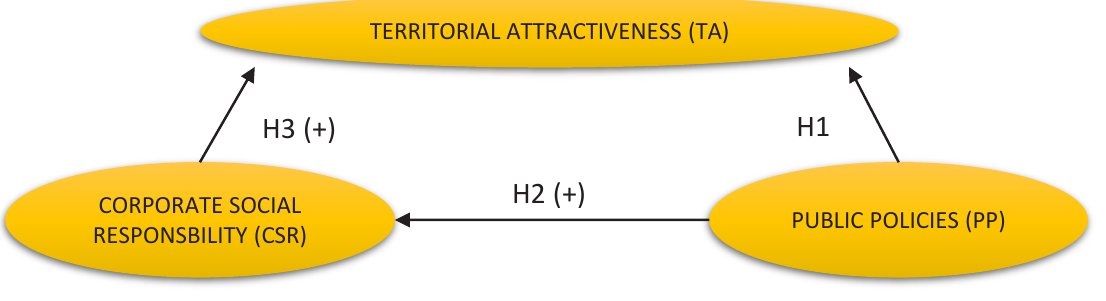
Figure 4. Proposed conceptual Table 2. Profile of respondents